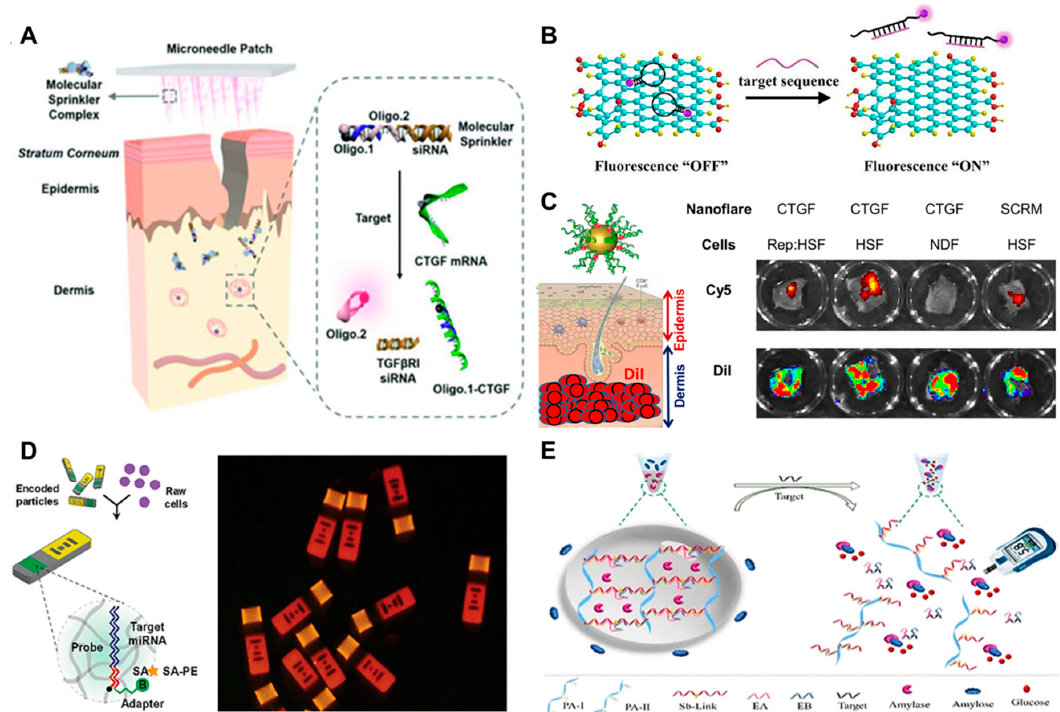
Figure 4. Molecular probes, nanotechnology, and hydrogel platforms for detecting nucleic acid biomarkers. Hydrogel MNs or particles can encapsulate or be coated with molecular or nanoprobe assembly for direct/indirect nucleic acid detection: ( A ) Molecular sprinkler assembly for